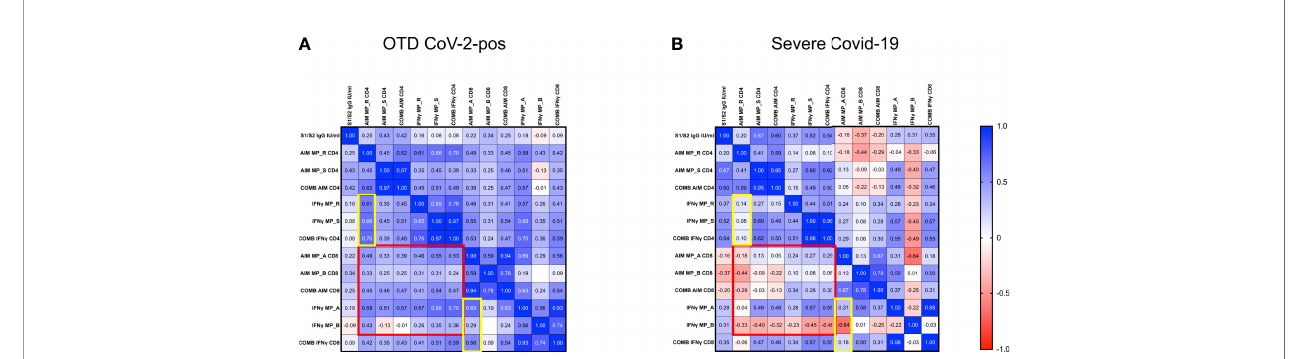
FIGURE 7 | Disorganized immune responses in Severe COVID-19 patients. Spearman ’ s correlation matrix and clustering of 13 features in 33 OTD-CoV-2 pos (A) and 22 severe COVID-19 patients (B) . The scale code is shown on the right side (blue and red colors indicate positive and negative correlations, respectively).